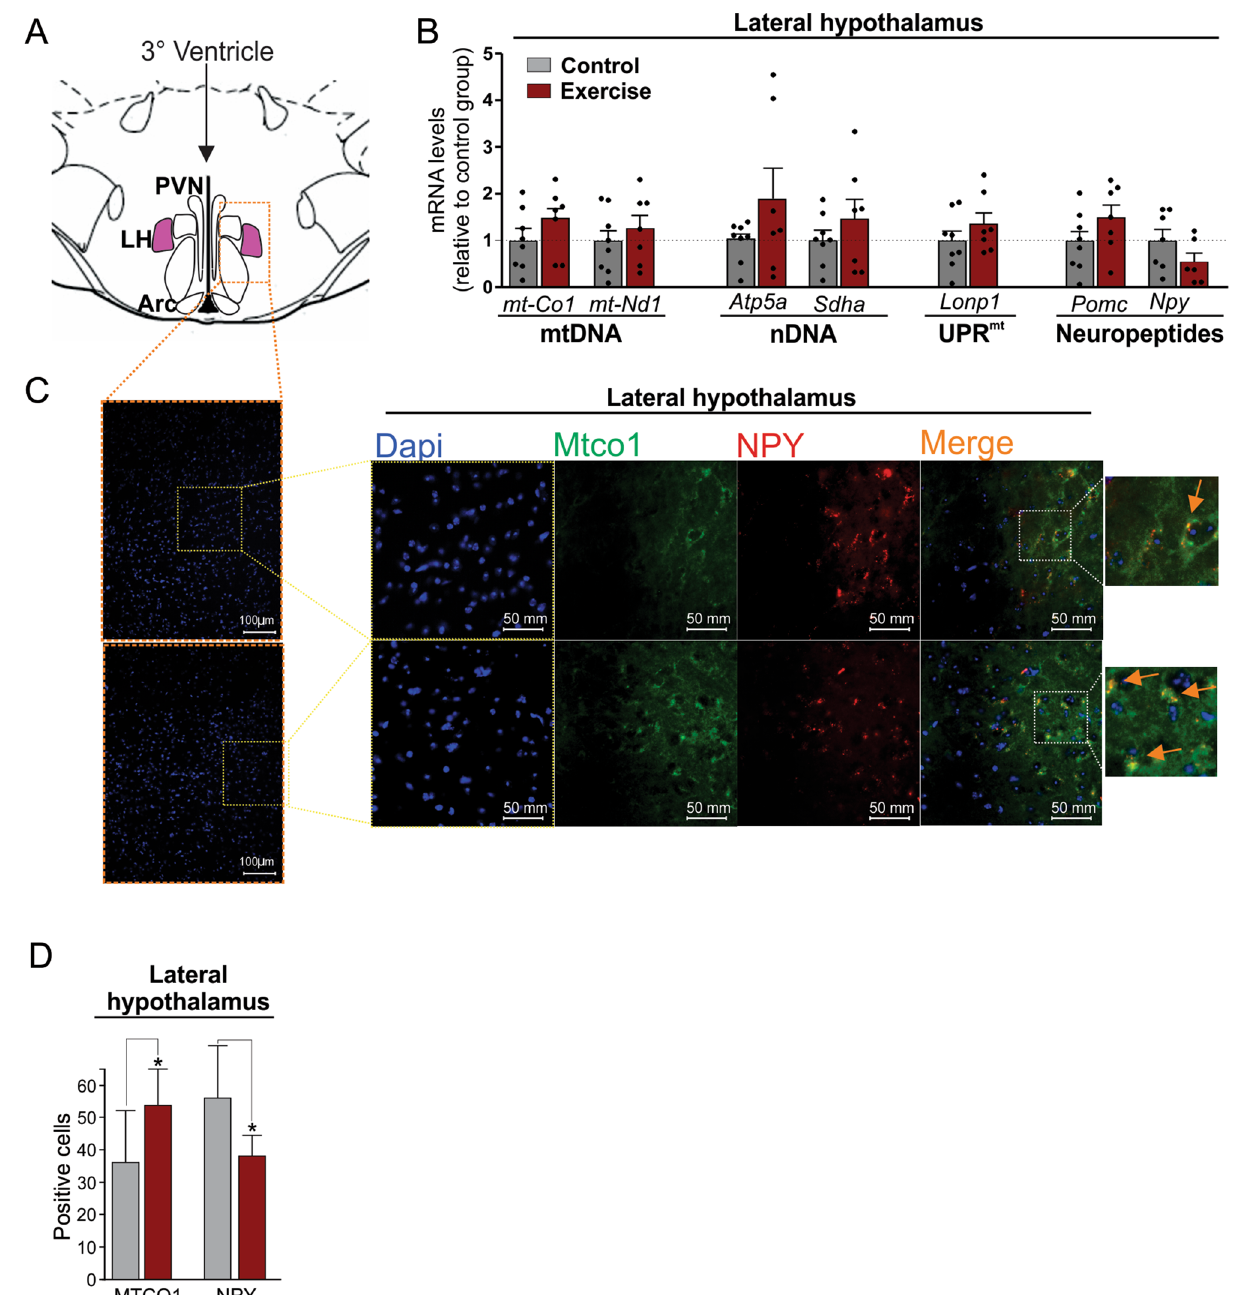
Figure 6. Evaluation of hypothalamic mt-Co1 mRNA levels and orexigenic factors. ( A ) Schematic view of hypothalamic nuclei, highlighting the lateral hypothalamus. ( B ) Genes expression assessment. Student’s t-test (two-tailed). (n = 7–8 per group). ( C ) Immunofluorescence assay showing DAPI staining (200 and 400 × magnification) and the presence of mt-CO1 (green) in NPY (red) in neurons of the lateral hypothalamus nucleus of mice (400 × magnification) and the spotlighted image was acquired by using digital zoom. Orange arrows indicate mt-CO1/NPY colocalized neurons. ( D ) Quantification of mt-CO1 and NPY in the lateral hypothalamus of mice. Student’s t-test (two-tailed). * p < 0.05 versus control group (n = 3–4 per group). All figures were created in CorelDRAW 2019 software (version 21.0.0.593—https ://www.corel